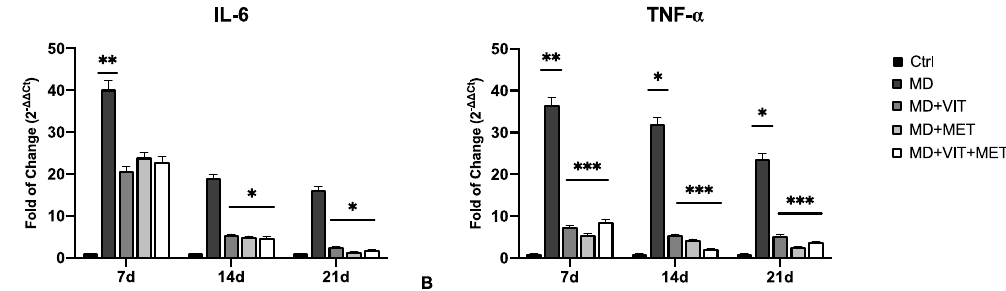
Figure 2. The expression of IL-6 ( A ) and TNF- α ( B ) was evaluated after 7, 14 and 21 days in ADSCs cultured in the presence of adipogenic differentiation medium (MD) (blue bars), or in MD plus vitamin D (MD+VIT) (yellow bars), or in MD plus metformin (MD+MET) (orange bars), or in MD with both metformin and vitamin D (MD+VIT+MET) (red bars), as compared to control untreated cells (grey bars). The mRNA levels for each gene were normalized to Glyceraldehyde-3-Phosphate-Dehydrogenase (GAPDH) and expressed as fold of change (2 −∆∆ Ct ) of the mRNA levels observed in undifferentiated control ADSCs defined as 1 (mean ± SD; n = 6). Data are expressed as mean ± SD referred to the control (* p ≤ 0.05; ** p ≤ 0.01; *** p ≤ 0.001).